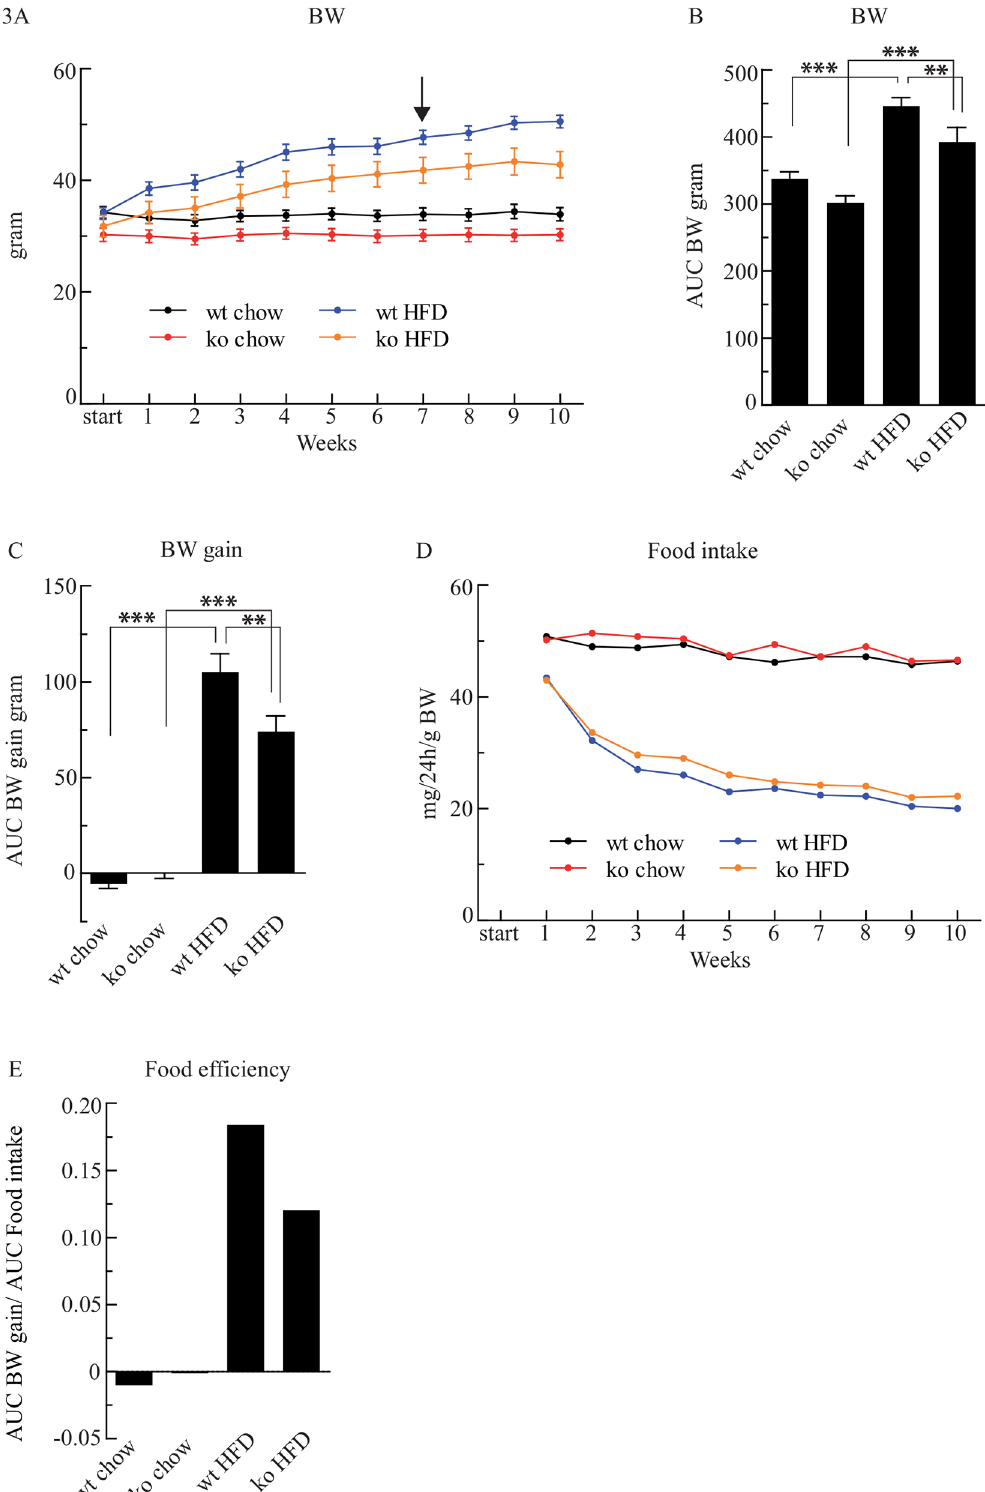
Fig 3. Cyp8b1 -/- (ko) mice show improved resistance to body weight (BW) gain following exposure to a high fat diet (HFD) and display lowered food efficiency index than Cyp8b1 +/+ (wt) mice. Body weight (A) and area under the curve (AUC) (B) . The arrow denotes the time point at which a significant difference in body weight between Cyp8b1 -/- and Cyp8b1 +/+ mice on HFD first occurred, and this difference persisted throughout the experiment. Body